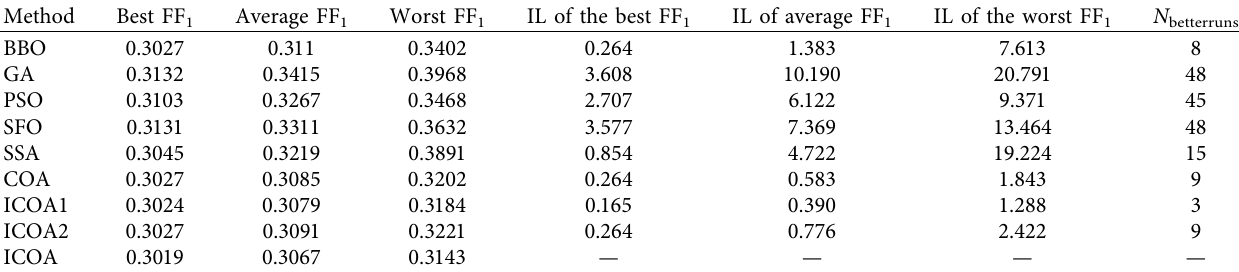
Table 13: The comparison among nine methods of the IEEE 69-bus distribution network for the second case. Method